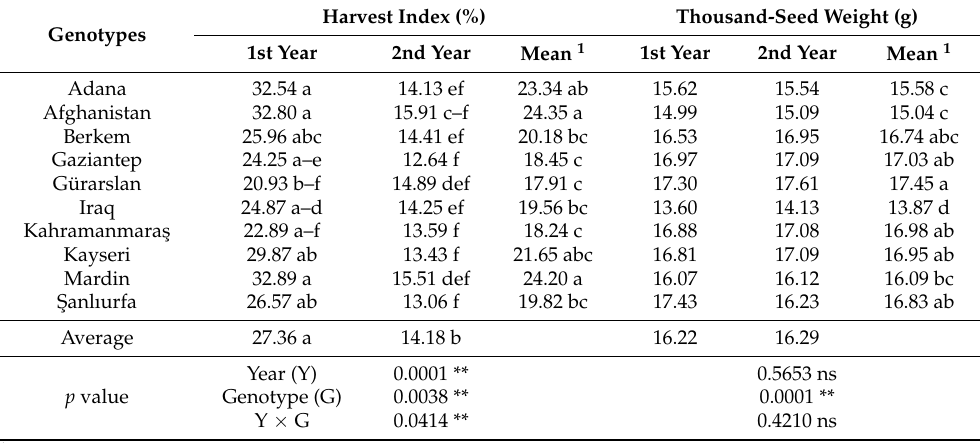
Table 7. Average values for the harvest index (HI) and thousand-seed weight of fenugreek genotypes.